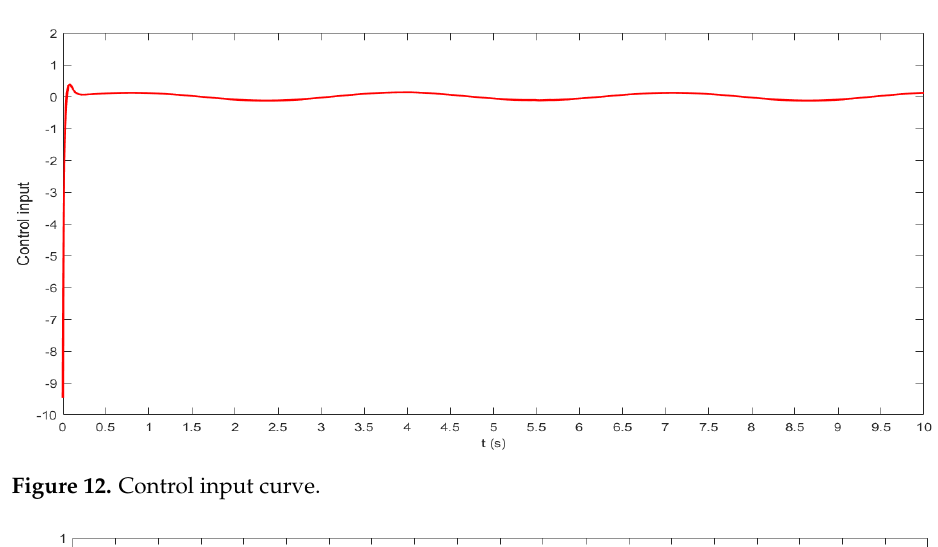
Figure 11. Speed tracking curve of a maglev train.